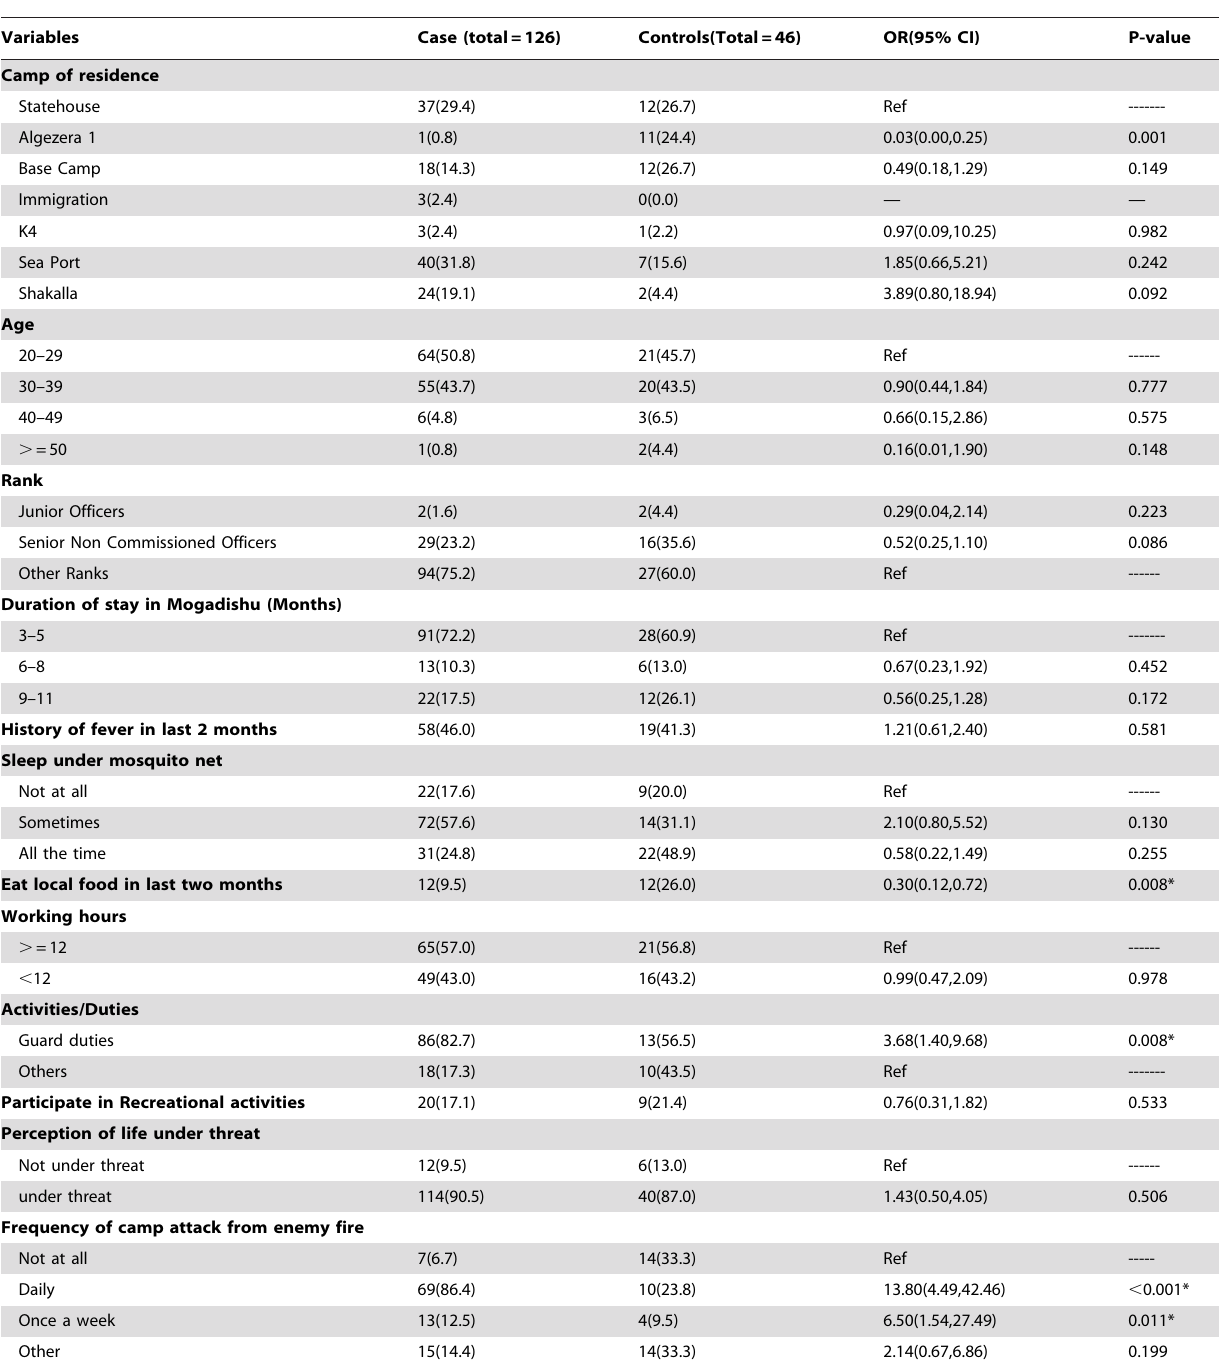
Table 2. Results of case control study conducted August 19–21, 2009 in Mogadishu,